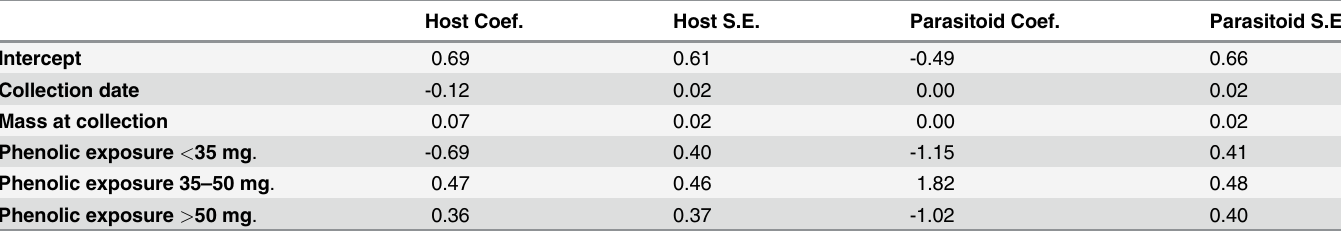
Table 1. Multinomial logistic model of the effects of a cluster of phenolic compounds on host and parasitoid survival across development among larvae that survived to at least 50 mg. Host Coef.